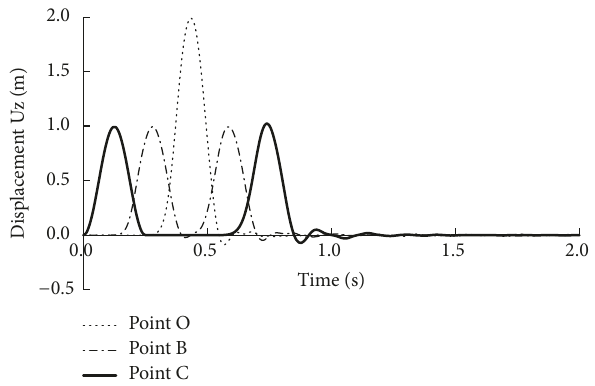
Figure 9: Numerical displacement of Method 2.